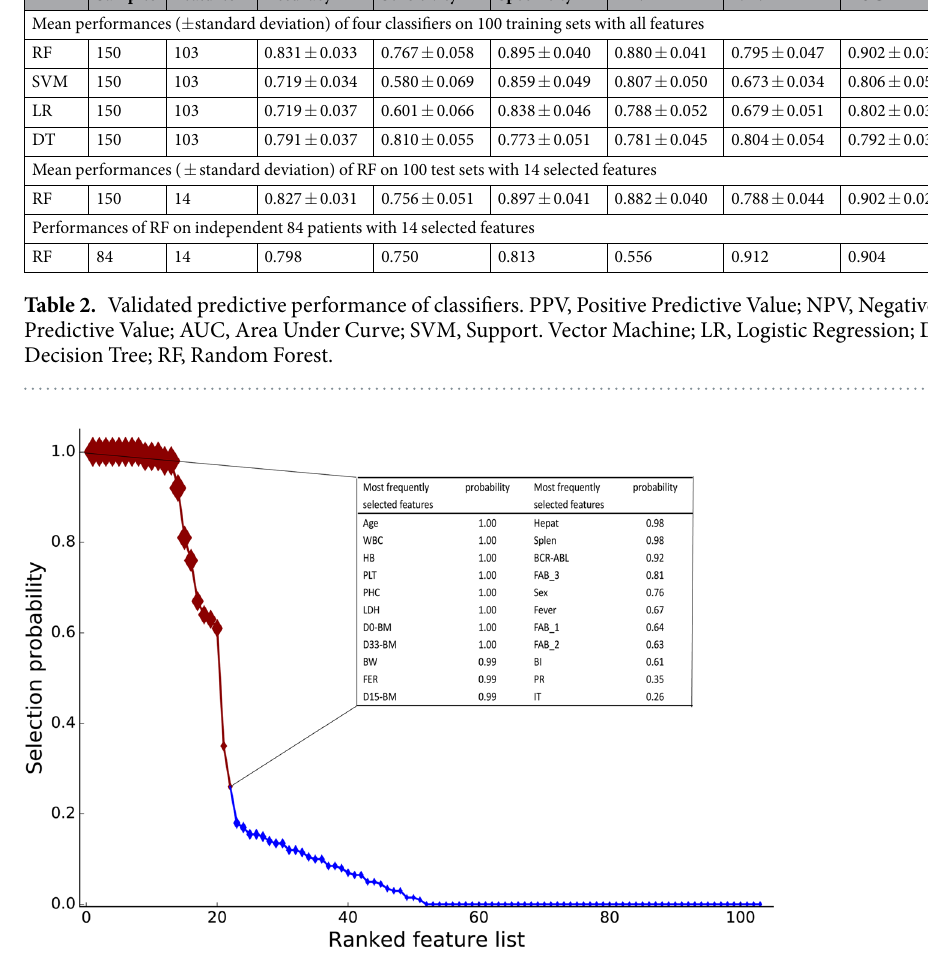
Figure 1. Composition of predictive variable sets selected by the nested cross-validation strategy. The features were ranked according to the selection probability measured across the 100 training sets. Variables with selection probability > 20% were marked by red rhombuses and the details were shown in the upper right inset. WBC, White Blood Cell count; HB, Haemoglobin; PLT, Platelet; PHC, Peripheral Heterotypic cell; LDH, Lactic Dehydrogenase; D0-BM, Lymphoblast in Bone Morrow at diagnosis; D33-BM, Lymphoblast in Bone Morrow on Day 33; BW, Birth Weight; FER, Ferroprotein; D15-BM, Lymphoblast in Bone Morrow on Day 15; Hepat, Hepatomegaly; Splen,